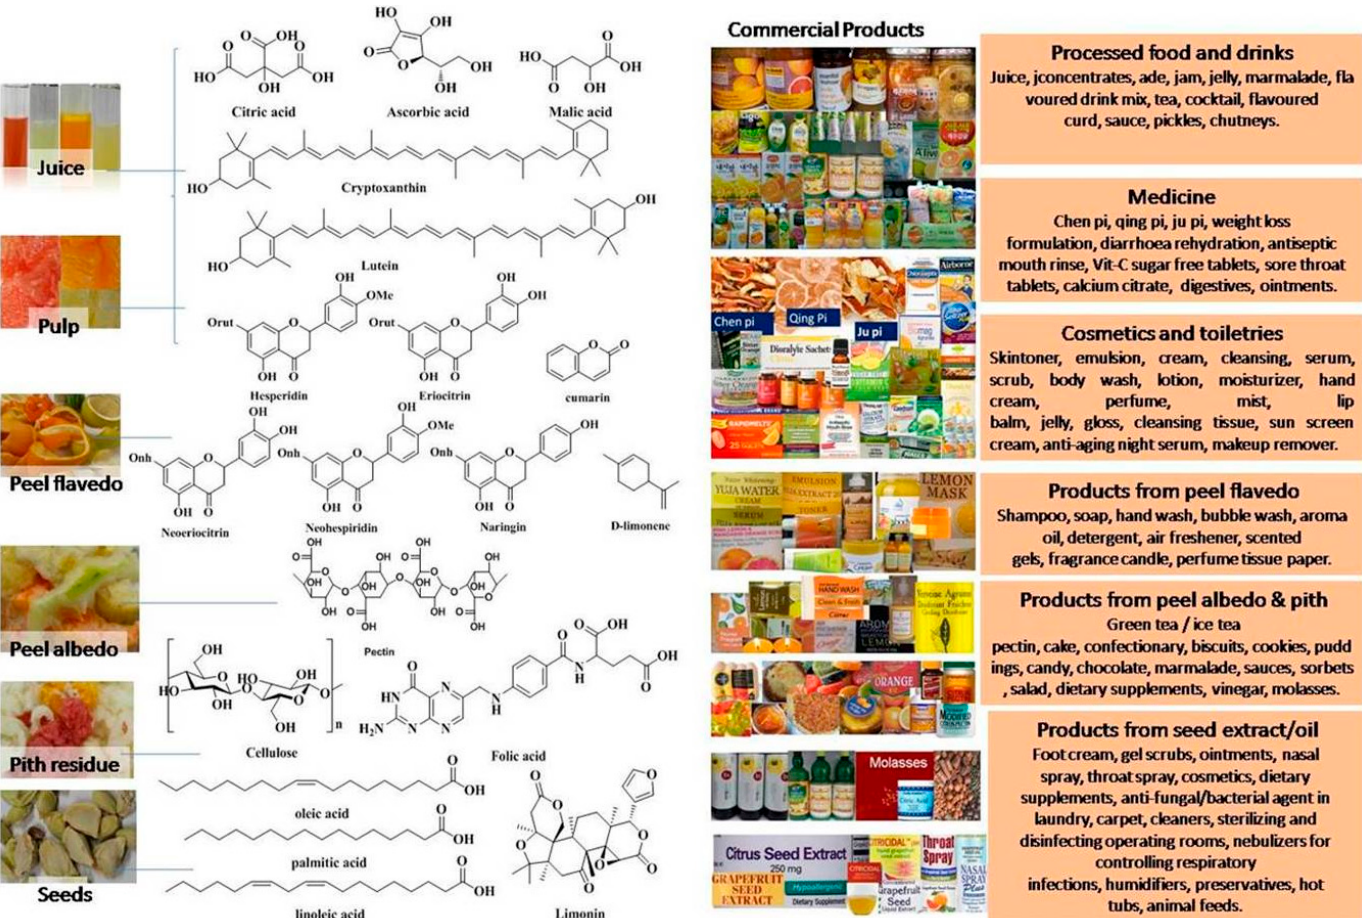
Figure 12. Byproducts obtained from citrus waste processing are utilized in manufacturing various types of commercial products. The photographs were collected from a local supermarket and have been used for academic purposes only and not for any advertising purposes.